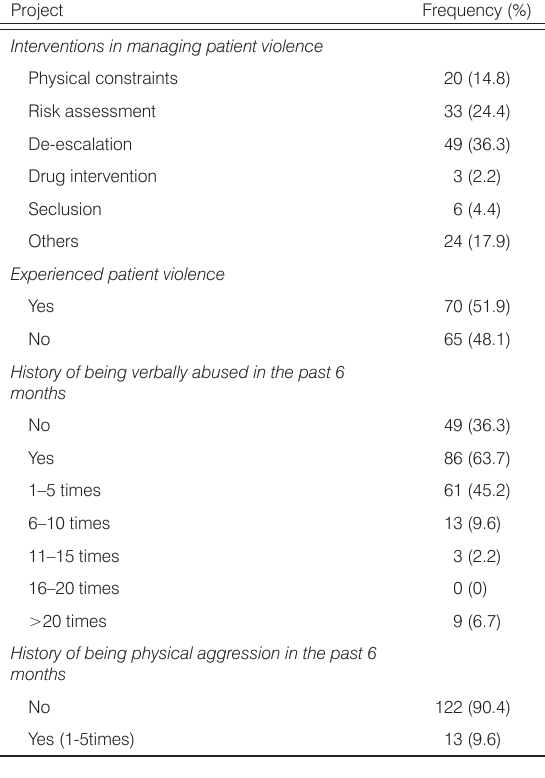
Table 1. General demographic data of the study ( n